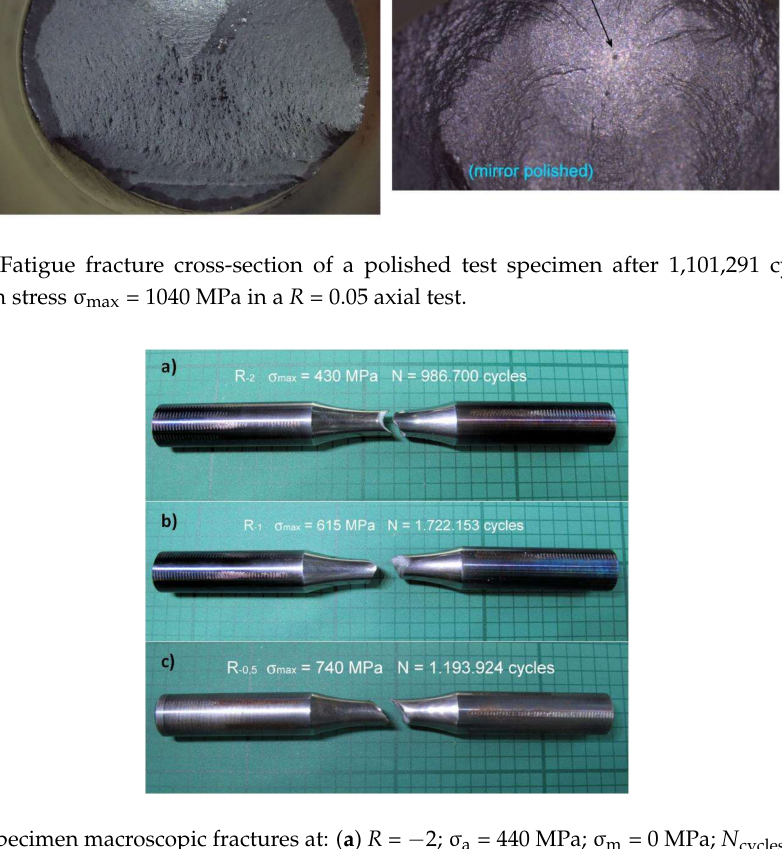
Figure 9. Specimen macroscopic fractures at: ( a ) R = − 2; σ a = 440 MPa; σ m = 0 MPa; N cycles = 986,700; ( b ) R = − 1; σ a = 430 MPa; σ m = 0 MPa; N cycles = 1,722,153; ( c ) R = − 0.5; σ a = 430 MPa; σ m = 0 MPa; N cycles =